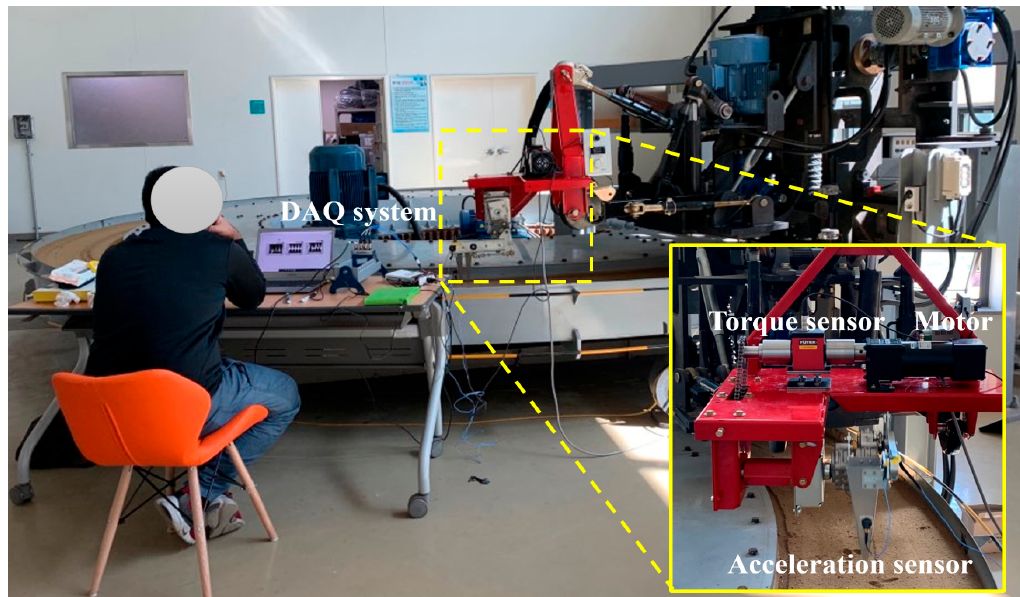
Figure 5. The planting device used in the experiment with an enlarged view of the sensor setup.